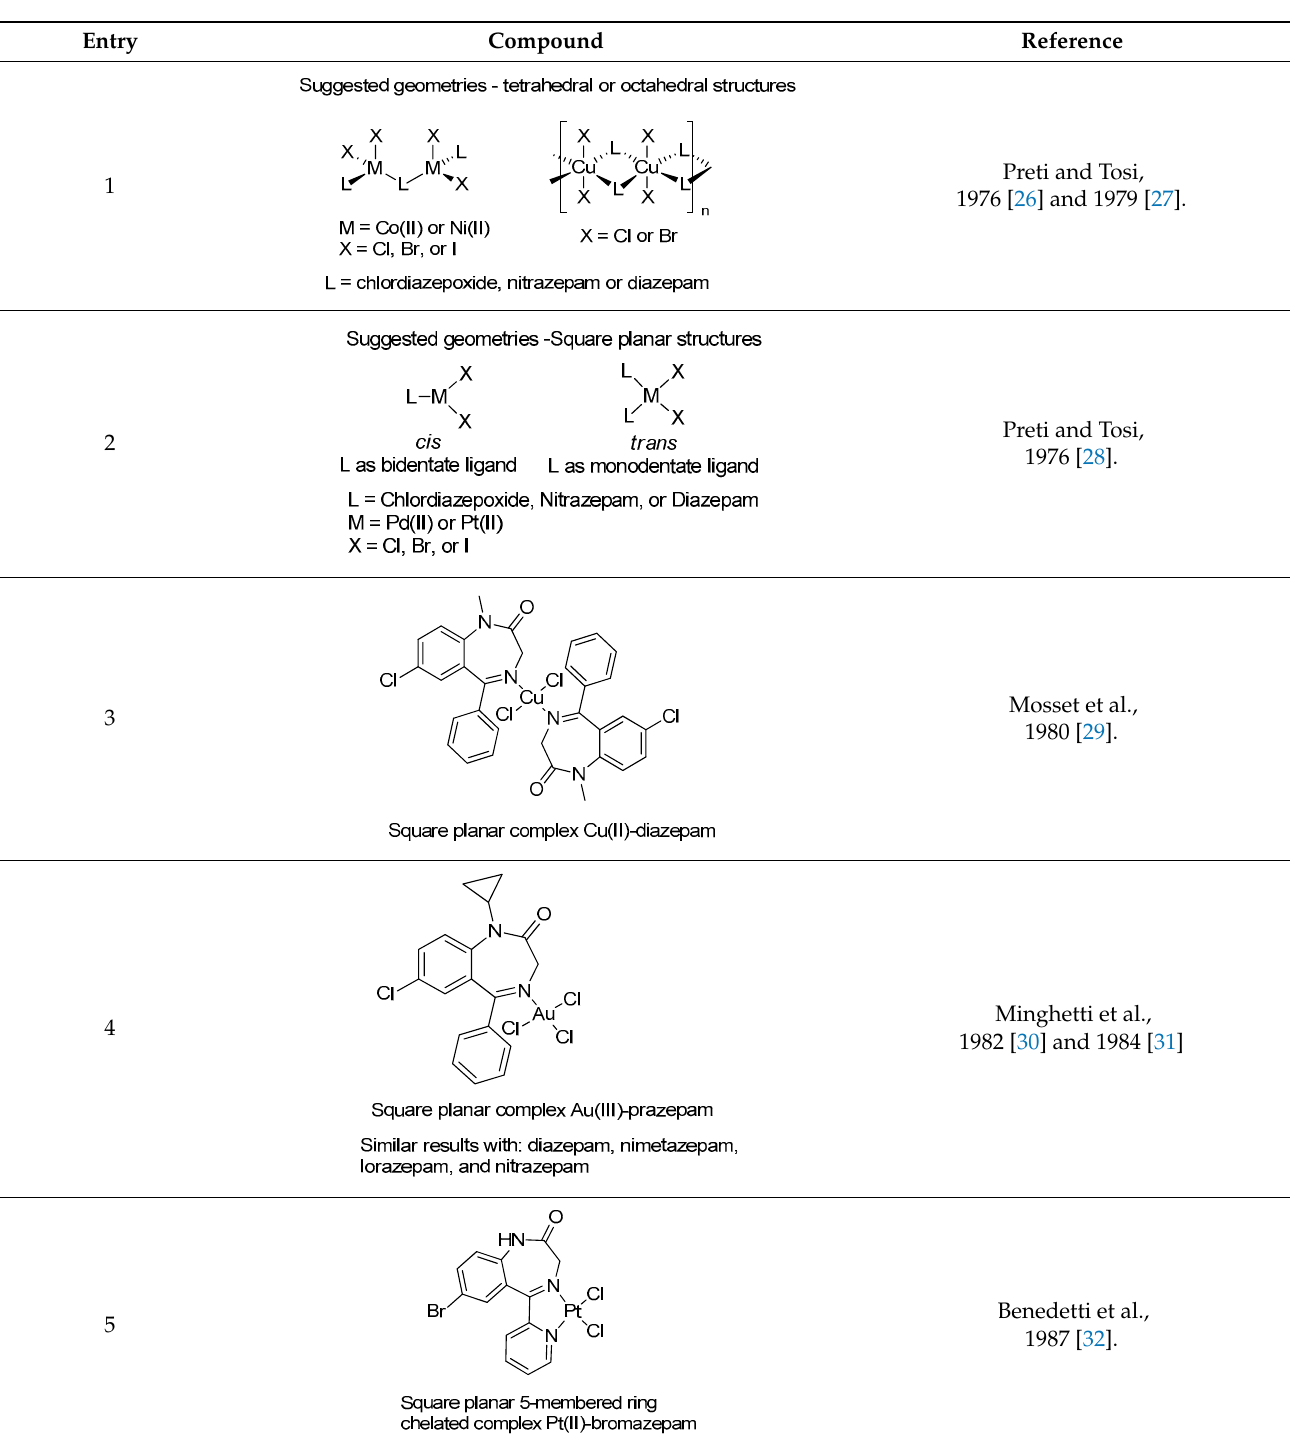
Table 1. Examples of organometallic and coordination compounds containing BZDs as ligands, illustrating the chronological evolution of the theme.